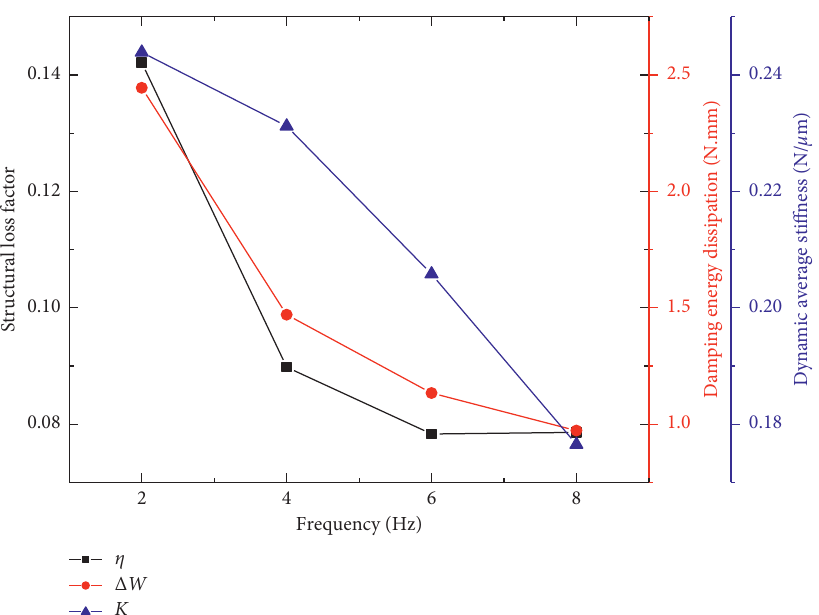
Figure 8: The evolution of damping characteristics under the condition of group 2 (( A ) � 150 μ m).